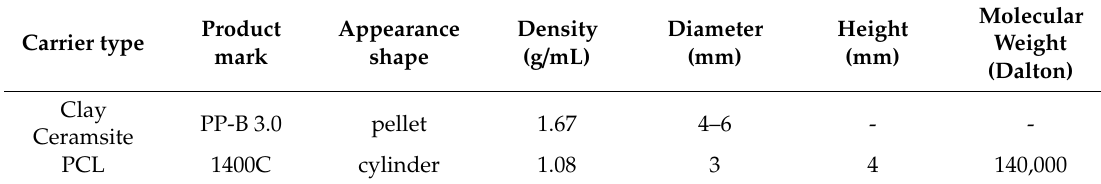
Table 1. Physico-chemical parameters of the two biofilm carriers in this